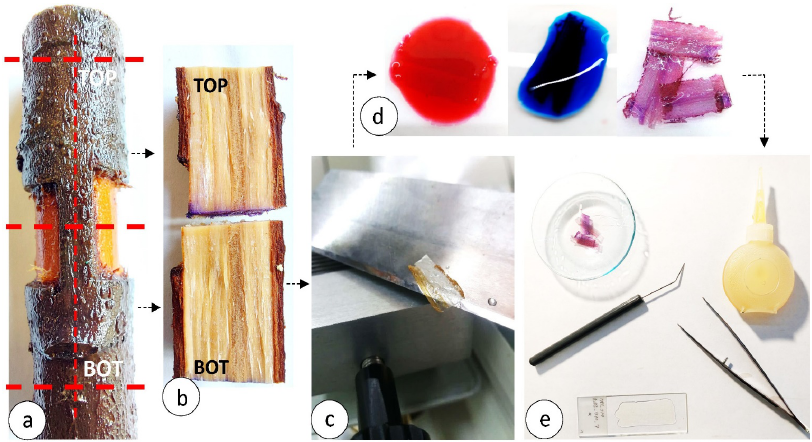
Figure 2. Mechanical injured stem of cherry laurel ( Prunus laurocerasus ); ( a ) sample PrLa_8 with preparation red mark; ( b ) split sample at the bottom (BOT) and top (TOP) at mechanical injury; ( c ) cutting histological slices for anatomical investigation with a sliding microtome; ( d ) staining of wood slices, and ( e ) tools used.